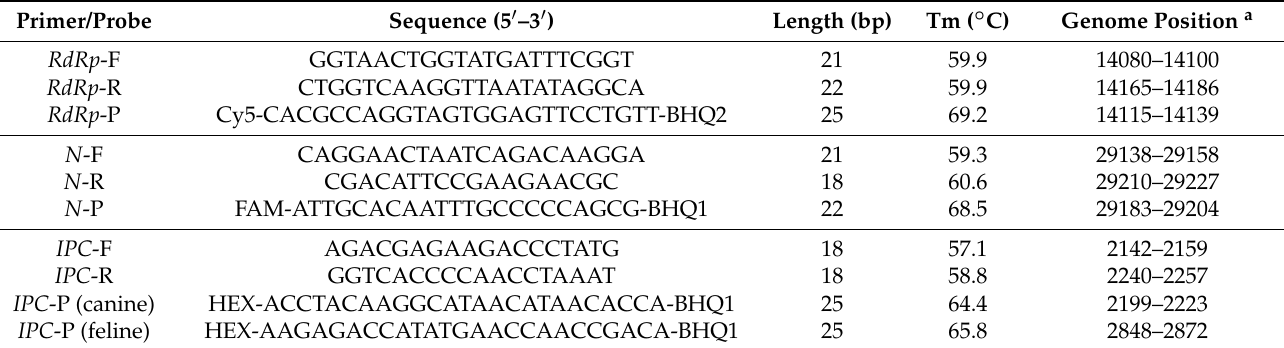
Table 1. Primers and probes used in the developed